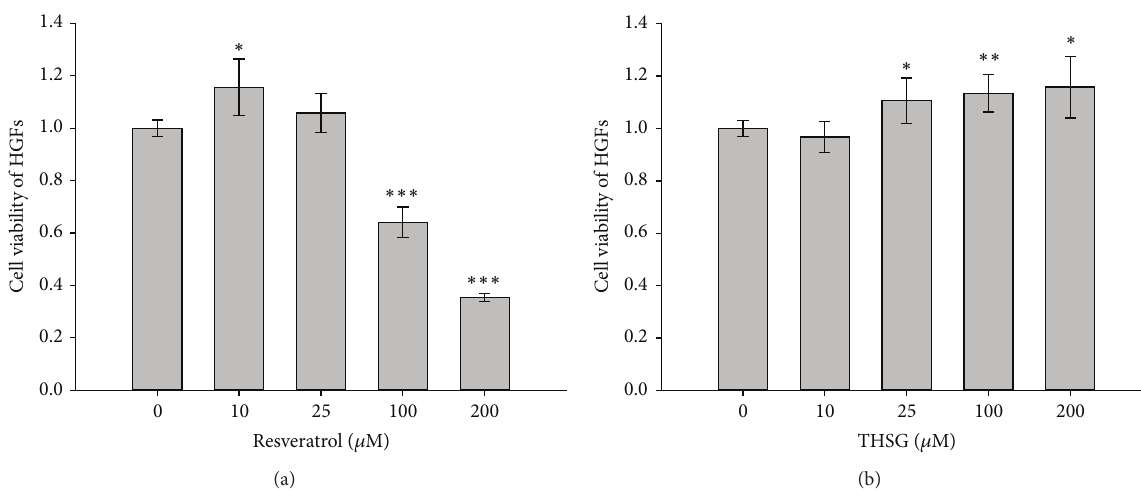
Figure1:ThecytotoxiceffectsofresveratrolandTHSGinHGFs.HGFs(1 × 10 4 cells/well)wereculturedin96-wellplateandthenwerestarved with serum-free DMEM/F12 medium for 24 h. After starvation, HGFs were treated with (a) resveratrol (0, 10, 25, 100, or 200 𝜇 M) or (b) THSG (0, 10, 25, 100, or 200 𝜇 M) in 0.25% stripped FBS medium for 72h with reflashed medium with agents daily. (Numbers of experiments are 5, 𝑁 = 5 ; ∗ 𝑝 < 0.05 ; ∗∗ 𝑝 < 0.01 ; ∗∗∗ 𝑝 < 0.001 were compared with solvent/DMSO